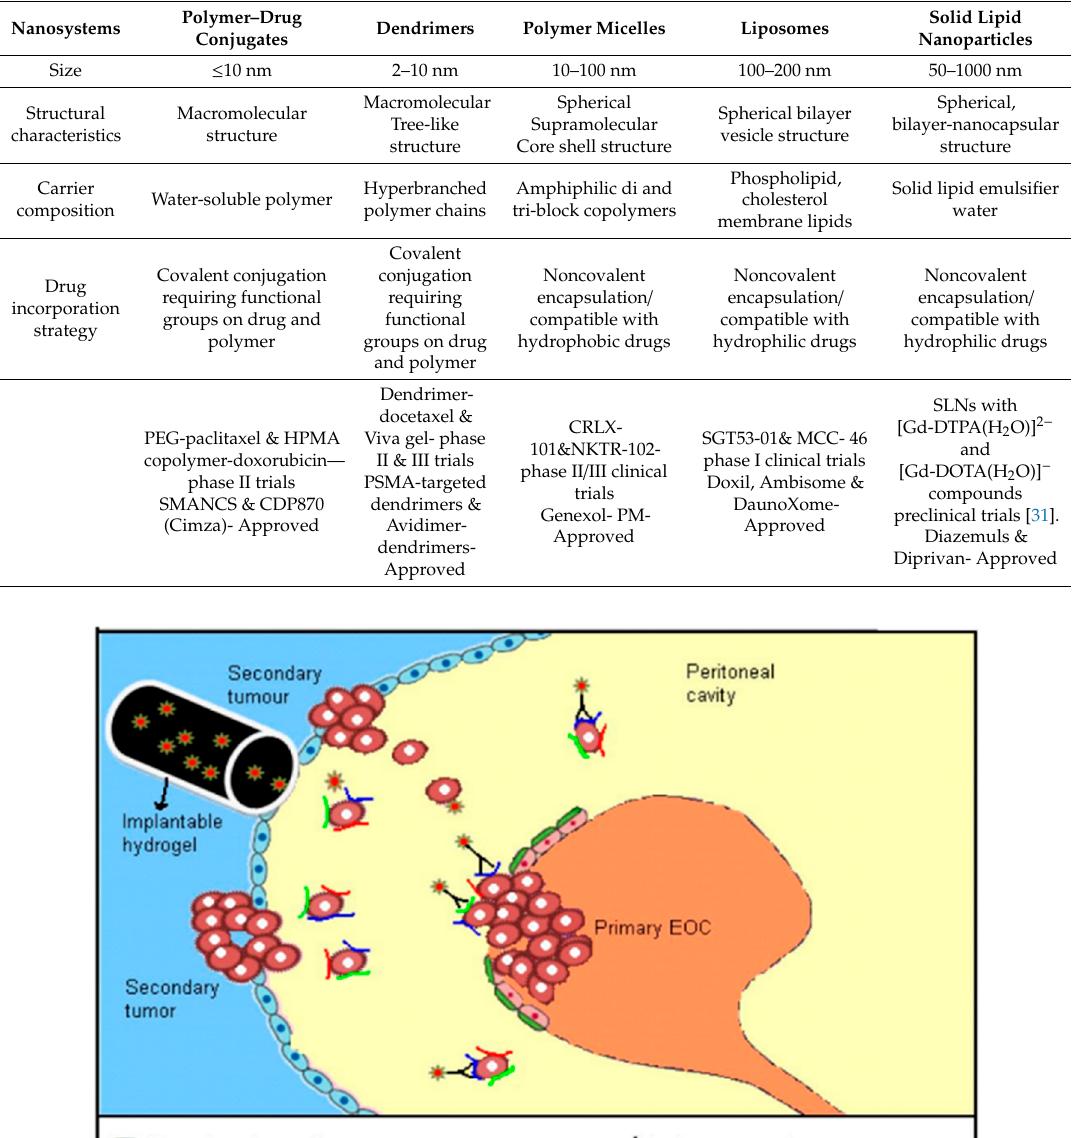
Table 1. Outline of the distinguishable nanotherapeutic tools designed for ovarian cancer treatment [19].